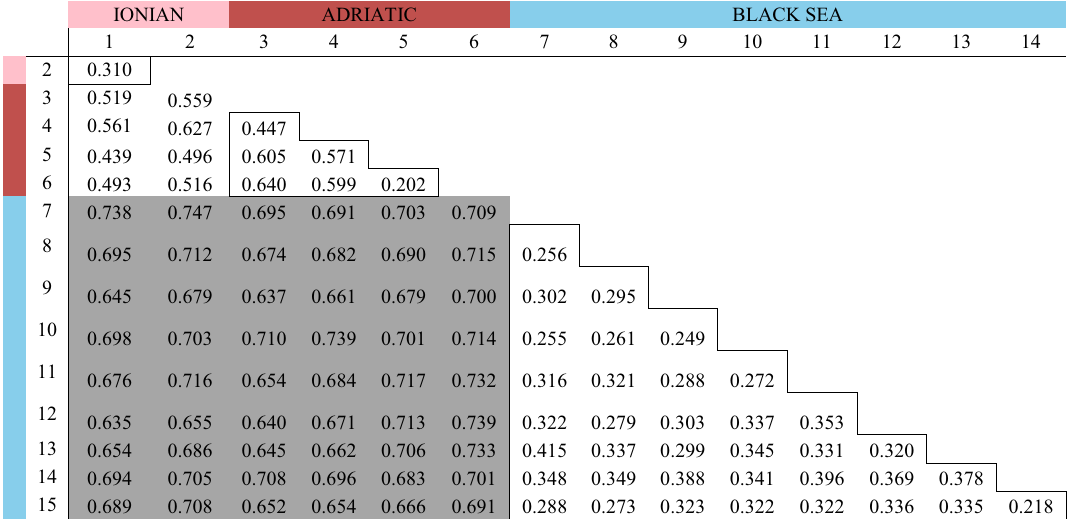
Table 3. Pairwise genetic distances estimated using Cavalli-Sforza and Edwards 137 for each pair of populations using the ENA correction 71 . Genetic distances in squares underlined values among sites sampled within a Sea (e.g. within the Ionian, Adriatic or Black Sea). Mediterranean Seas vs . Black Sea genetic distance estimates were highlighted in